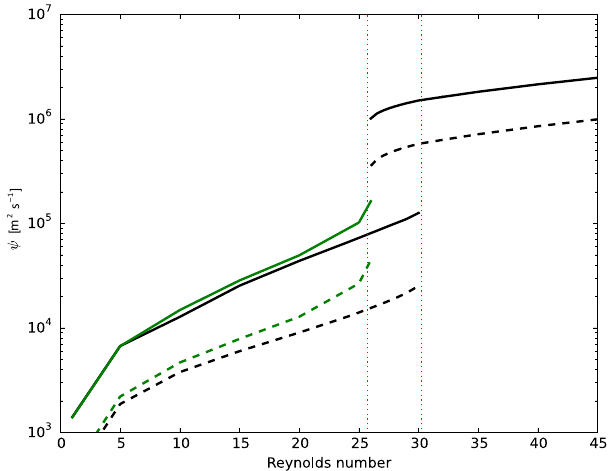
Figure 11. Part of the bifurcation diagram showing the upper and lower branches of steady and oscillatory solutions for a single-gyre ocean model. Shown are the mean (dashed) and maximum (solid) values of the stream function for QG (black) and ADCIRC (green) model runs, as a function of the Reynolds number Re . For ADCIRC the stream function is calculated as ψ = gζ/f 0 , where ζ is the free- surface height. The values shown represent time-averaged values in case the system shows oscillatory behavior. The flow undergoes a cyclic fold bifurcation near Re = 25, as indicated by the vertical dashed lines (Viebahn and Dijkstra, 2014). The ADCIRC solution becomes (numerically) unstable at this bifurcation.